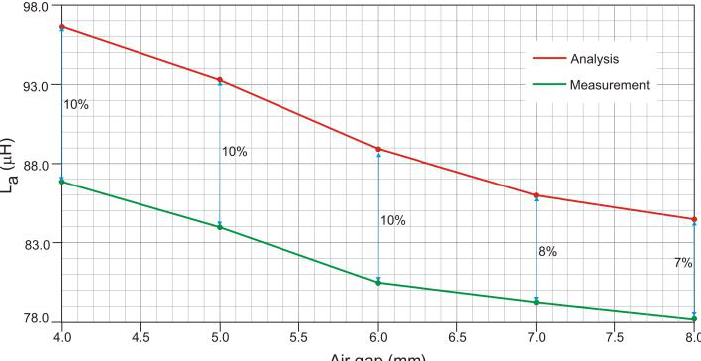
Figure 6. Self-inductance vs. air gap.